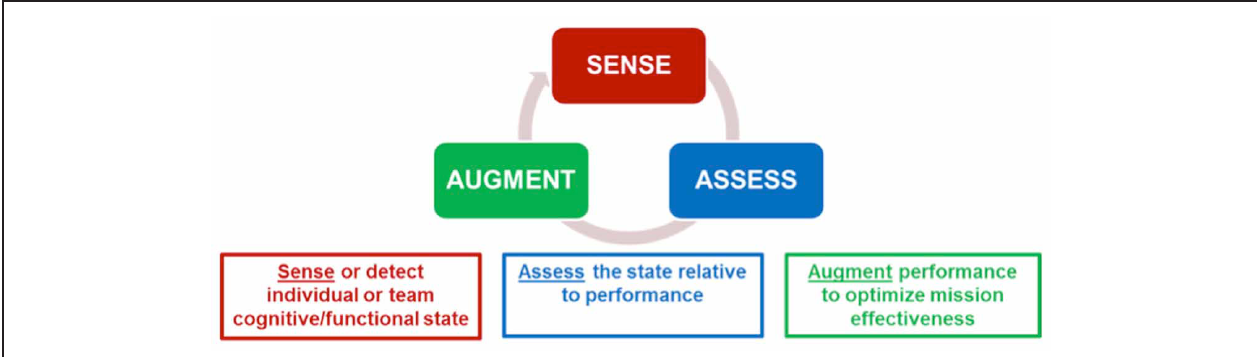
FIGURE 1 | Sense-Assess-Augment framework for optimizing threat detection performance. From Galster and Johnson